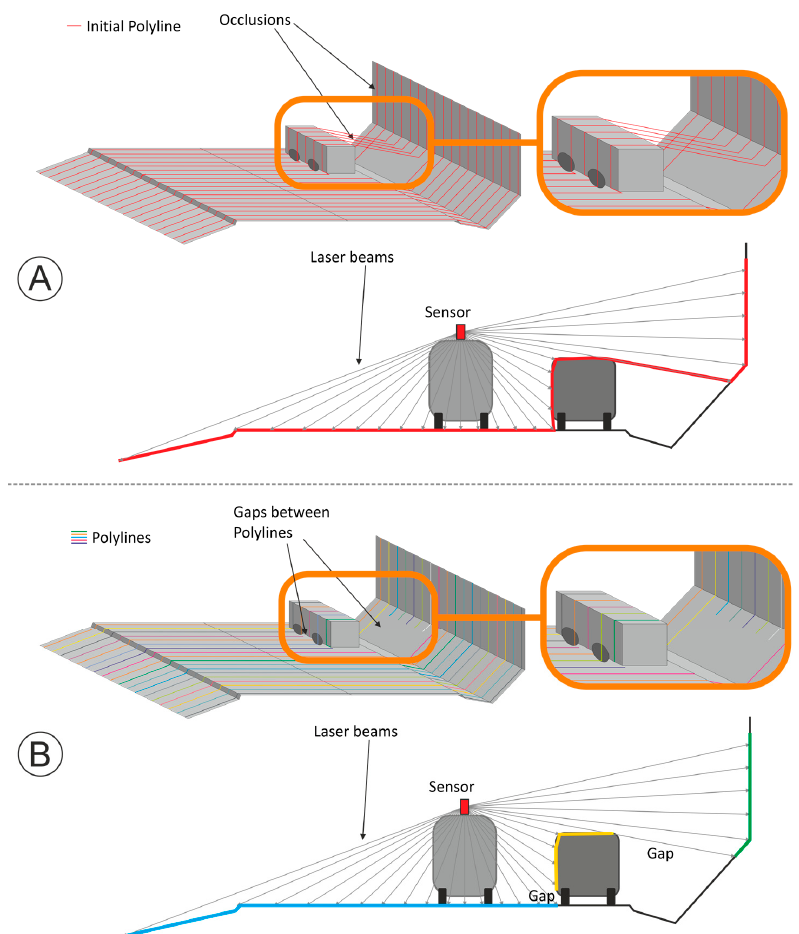
Figure 1. Result of MLS on a street corridor section. ( A ) perspective view and a section perpendicular to the trajectory of a single polyline as a result of joining all the consecutive points; ( B ) perspective view and a section perpendicular to the trajectory of randomly-colored polylines obtained from splitting the initial polyline at discontinuities or gaps.